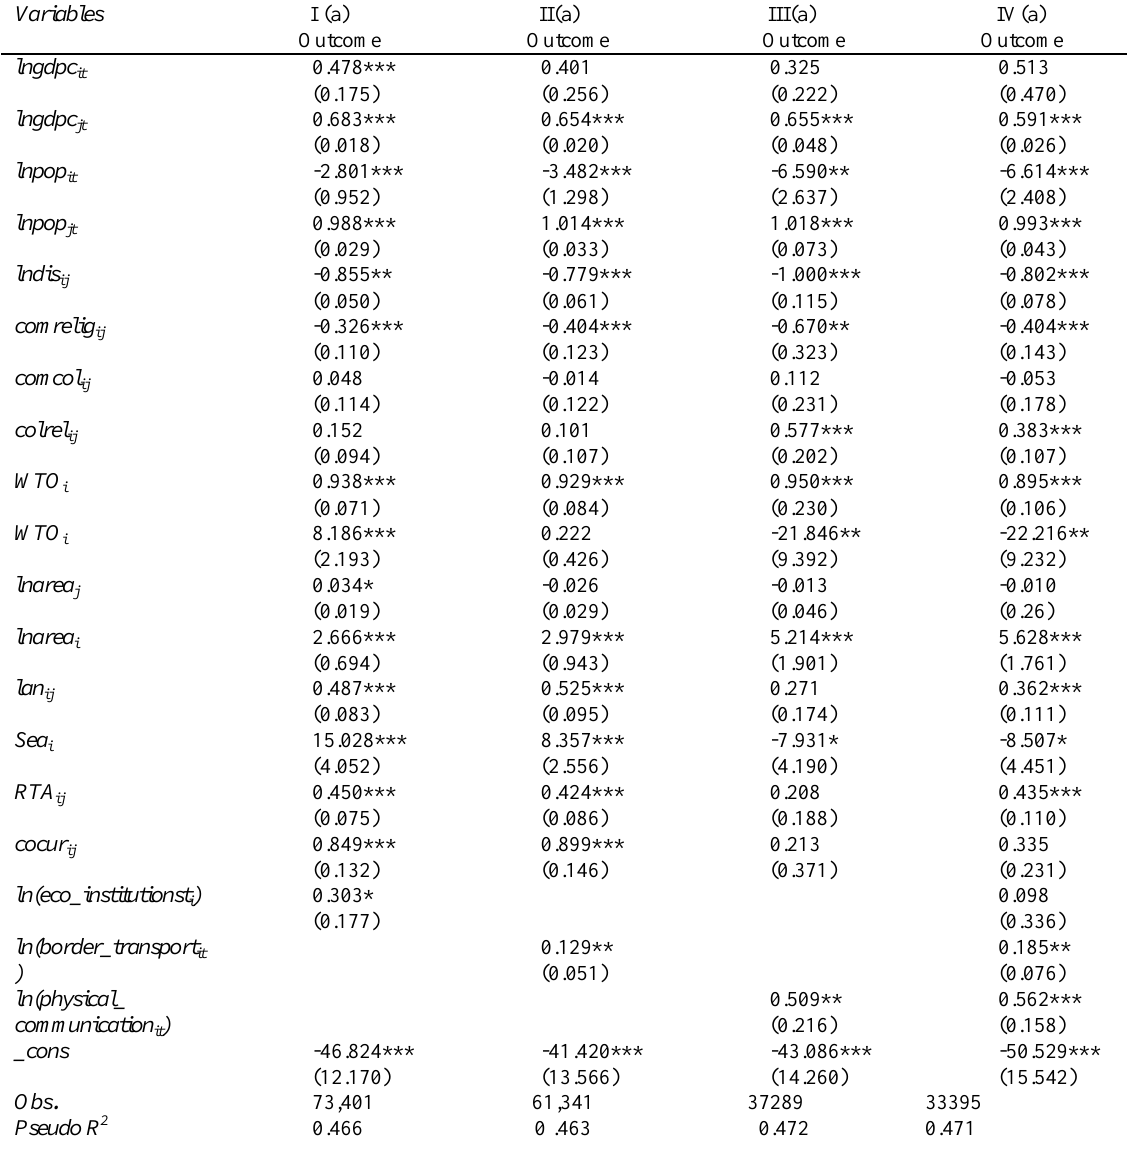
Table 12 : The impacts of border and transport efficiency, quality of economic institutions, physical and communication infrastructure on trade flow of African countries